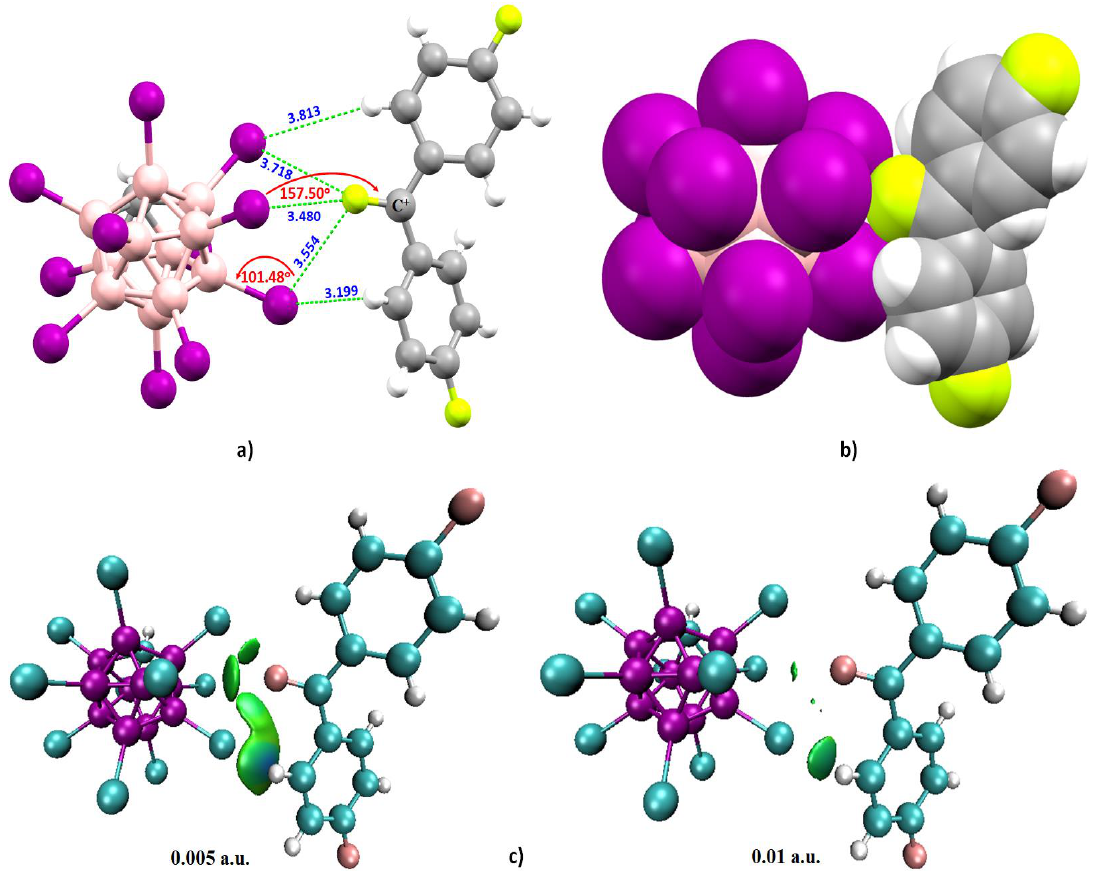
Figure 18. The crystal structure of fluoro(bis(4-fluorophenyl))methylium 1-carba-2,3,4,5,6,7,8,9,10,11,12-undecaiodododecaborate fluorobenzene (CSD ref: DEZFAQ). ( a ) Ball-and-stick and ( b ) space-filling models. A C 6 H 5 F solvate molecule has been omitted for clarity. Shown in ( c ) are the specific IGM representations of bonding interactions between interacting monomers, obtained with two different isovalues.